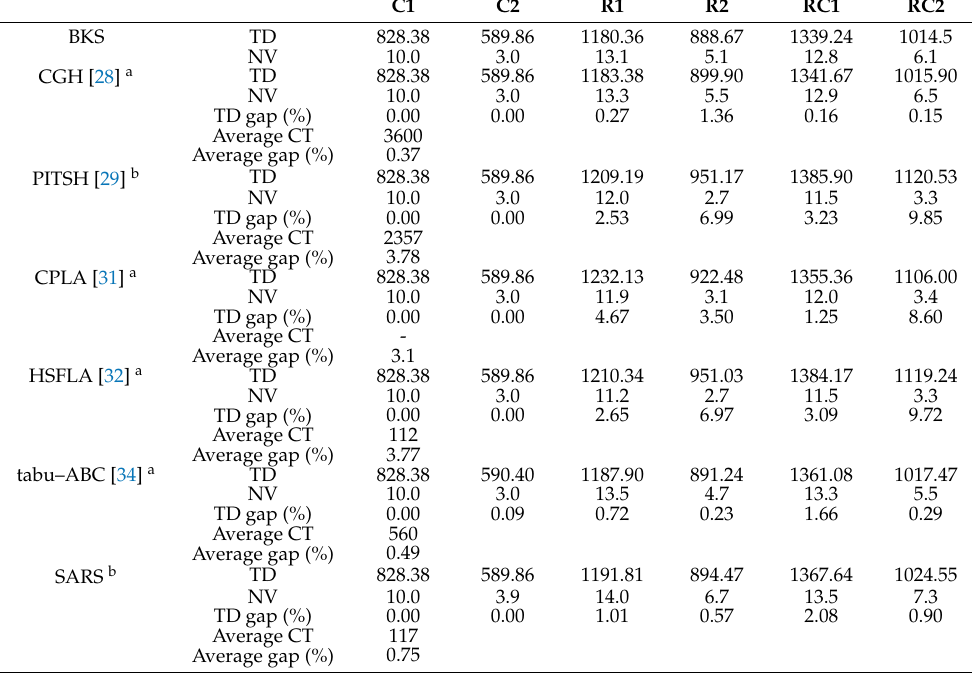
a = population-based solution heuristic. b = single-based solution